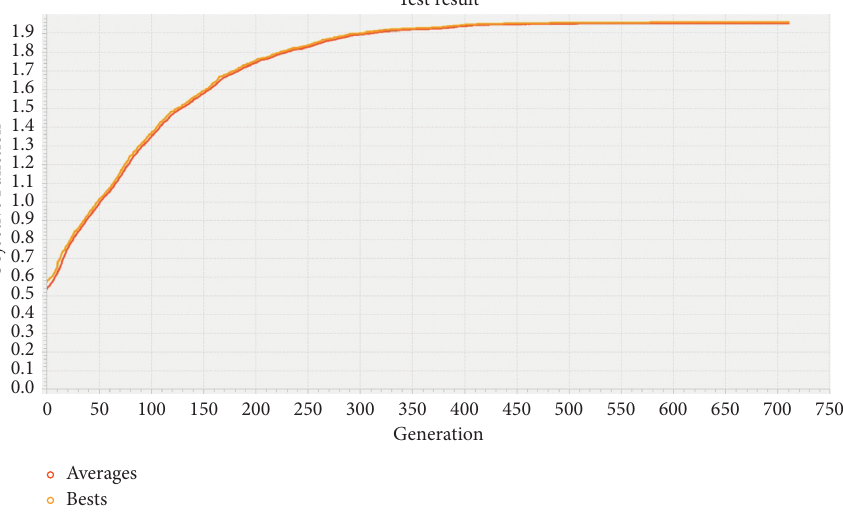
Figure 3: Collins convergence diagram of the data sample.